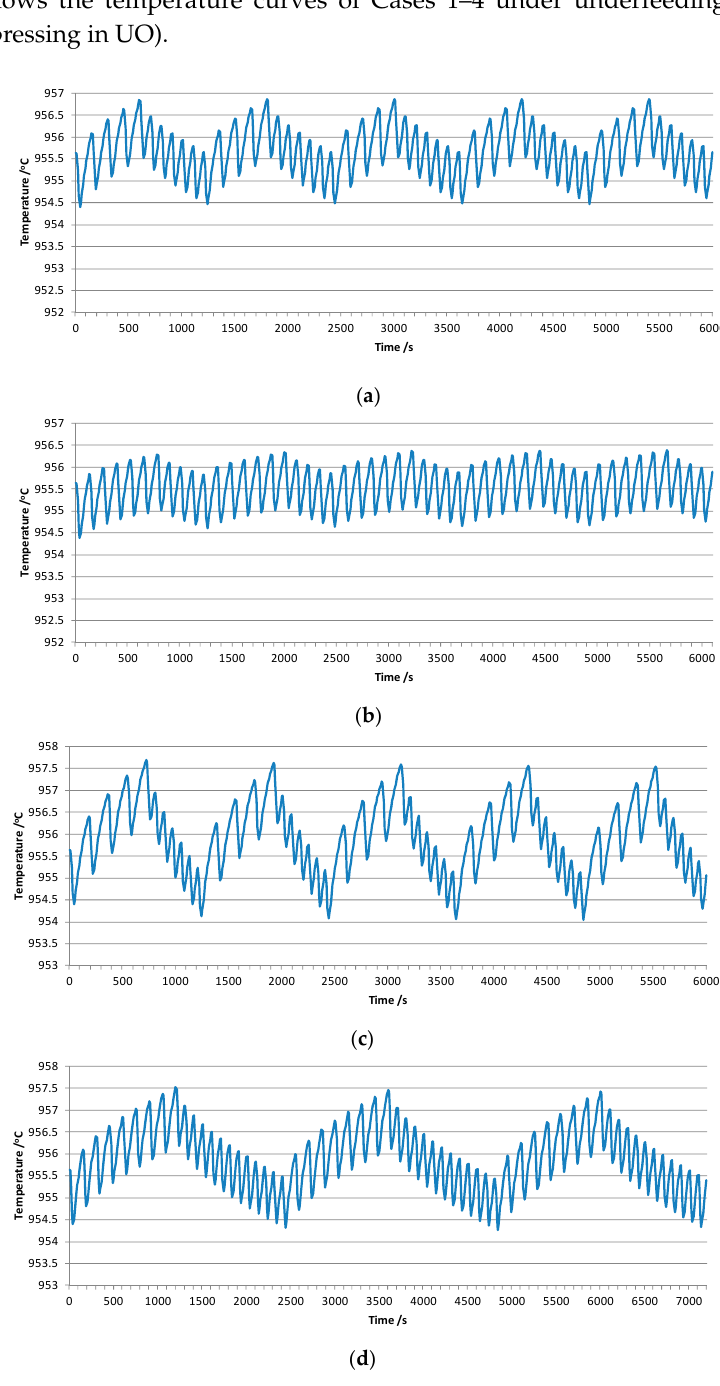
Figure 6. Temperature curves of Cases 1–4 under underfeeding followed by overfeeding. ( a ) Case 1 (UO), underfed (t = 150 s)–overfed (t = 100 s); ( b ) Case 2 (UO), underfed (t = 130 s)–overfed (t = 110 s); ( c ) Case 3 (UO), underfed (t = 180 s)–overfed (t = 80 s); ( d ) Case 4 (UO), underfed (t = 150 s)–overfed (t = 100 s).